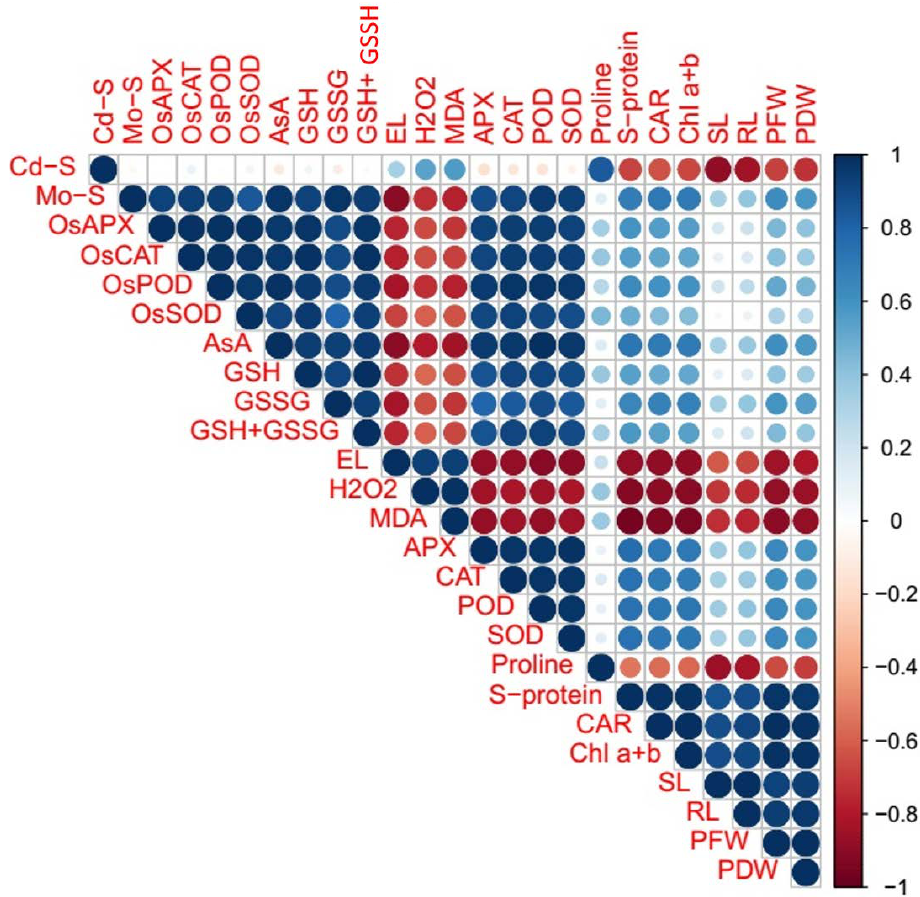
Figure 7. Correlation analysis between Mo and Cd application and growth attributes of fragrant rice